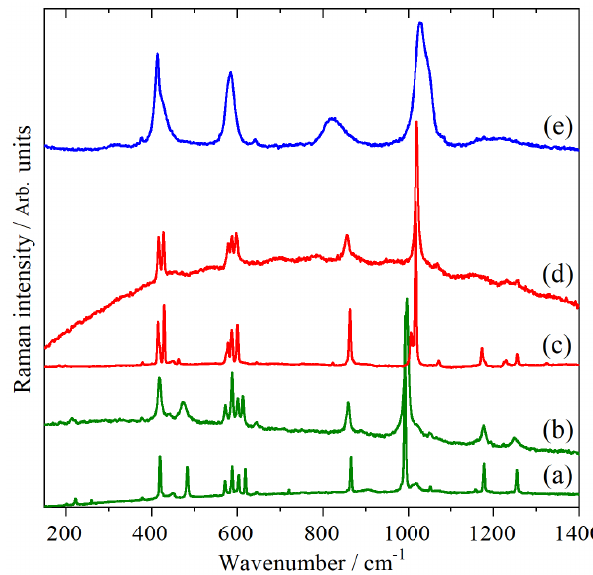
Figure 1. Raman spectra of CsHSO 4 in: phase III at ( a ) 10 K and ( b ) at 290 K, phase II at ( c ) 10 K and ( d ) at 300 K and phase I ( e ) at 430 K.